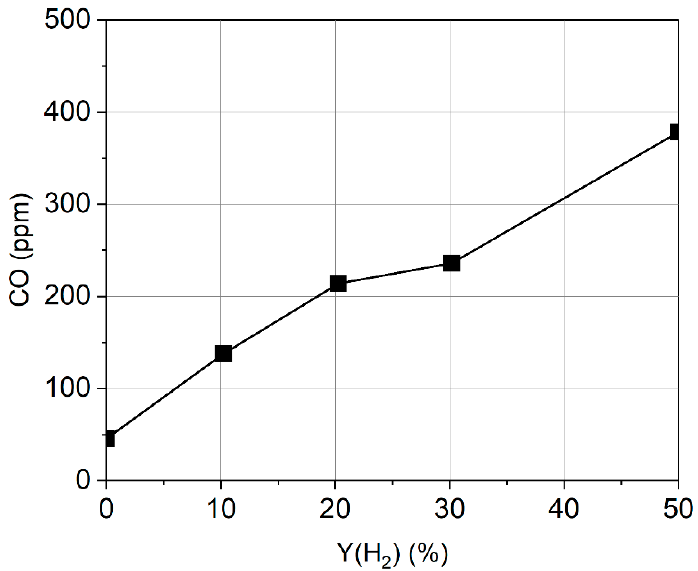
Figure 16. Dependence of CO emissions on the molar concentration of hydrogen in methane–hydrogen mixture [35,40].